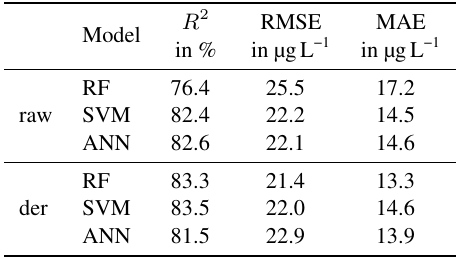
Table 5. Regression results for chlorophyll a estimation with 12nm spectral resolution for the raw dataset (raw) and the dataset with derivatives (der).